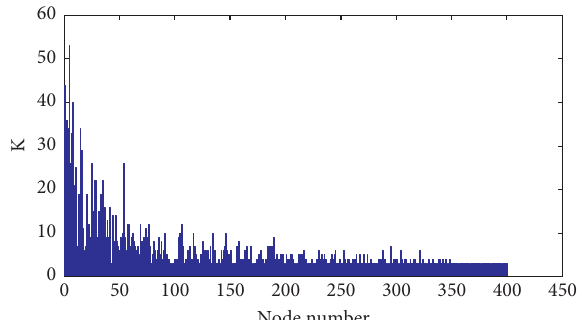
Figure 3: Degree distribution of each node in scale-free network (when n � 400, d � 6).